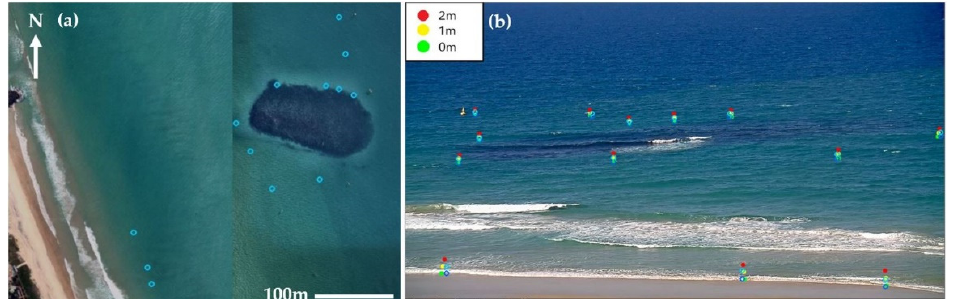
Figure 4. GPS verification map ( a ) and image ( b ). Unfilled blue points on the map show surveyed GPS points with corresponding points in the image (dark blue = 0 m LAT, light blue = 1 m LAT). Filled green, yellow and red points in the image were derived from the homography matrices for 0, 1 and 2 m LAT, respectively. Note that split aerial image ( a ) is not from the same date as ( b ), so shoreline sampled points in ( b ) are not supposed to plot on the shoreline in ( a